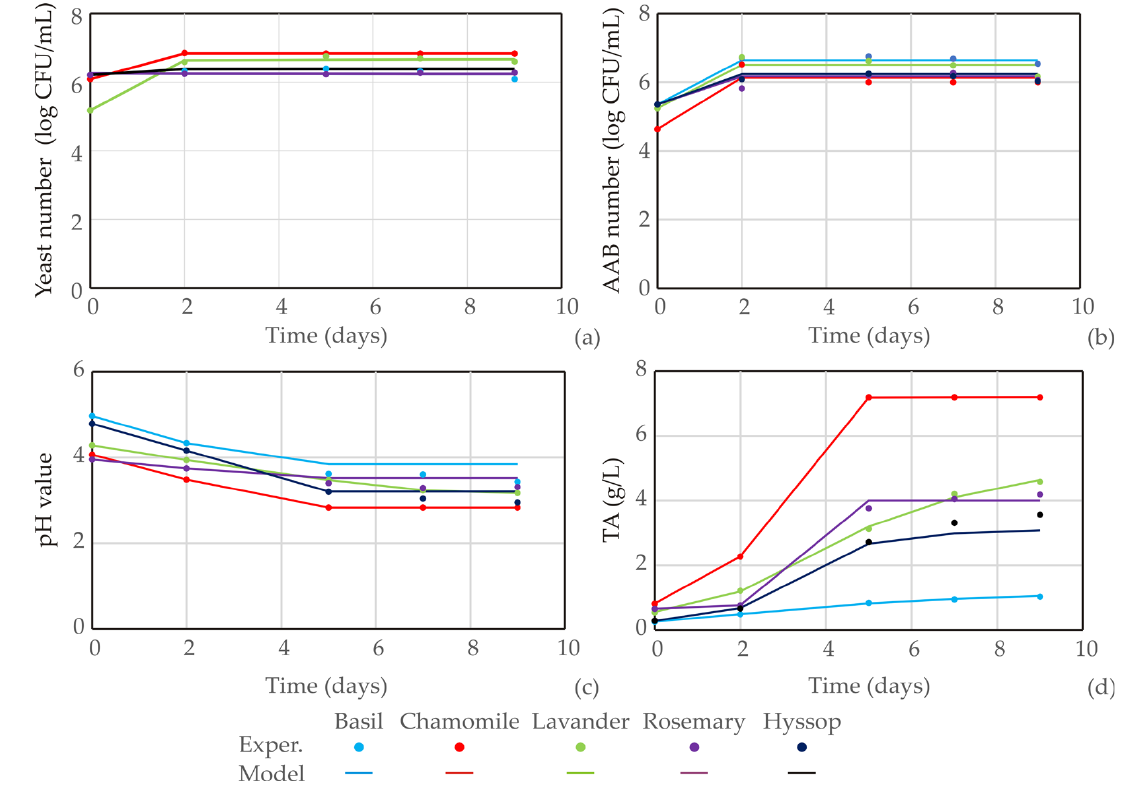
Figure 1. Experimental values (points) and kinetics curves (lines) for: ( a ) yeast number, ( b ) AAB number, ( c ) pH values, and ( d ) TA value during kombucha fermentation.